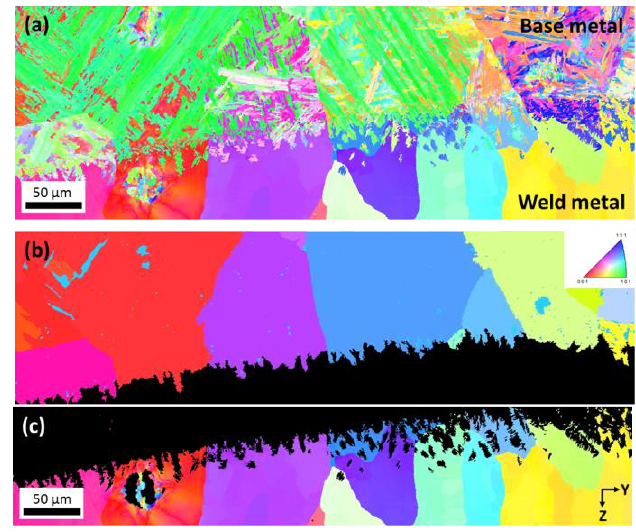
Figure 8. Results of the parent grains reconstruction with ARPGE software. ( a ) Initial EBSD map around the interface; ( b ) Crystallographic orientations of the former austenitic grains on the base metal side, calculated by ARPGE; ( c ) Crystallographic orientations of the austenitic grains on the weld metal side.